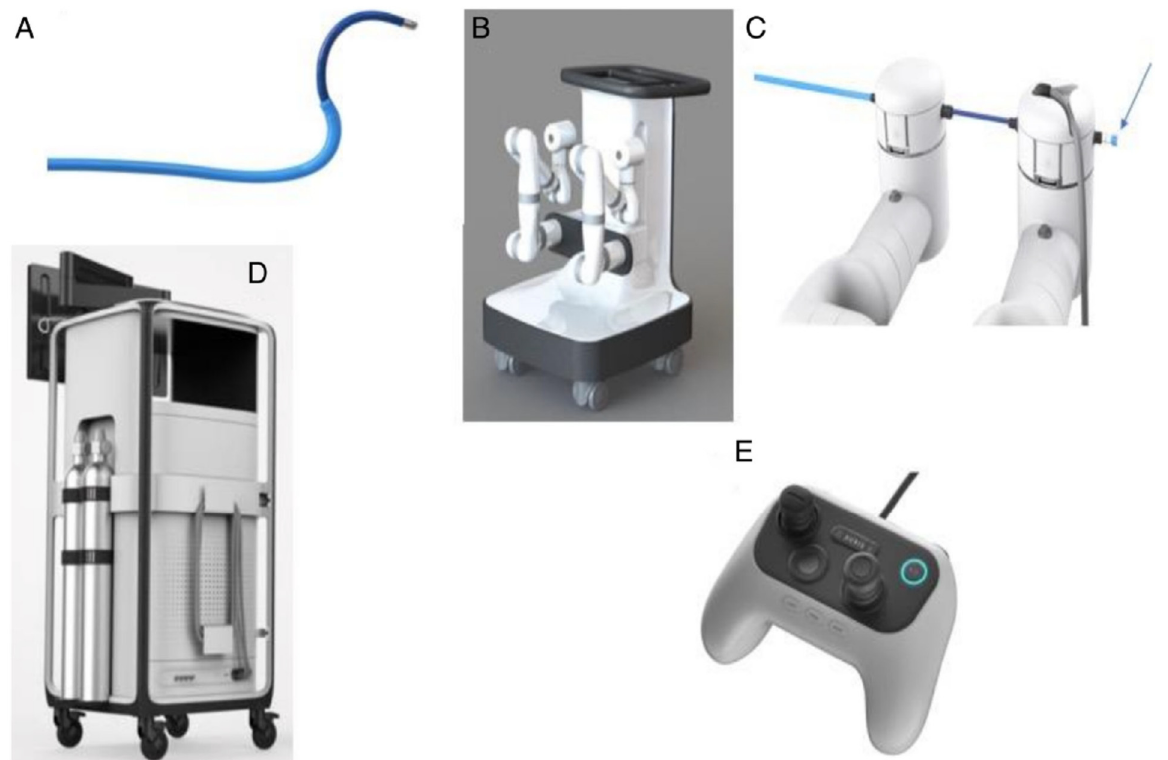
Figure 1. The Monarch TM Robotic System (Auris Robotics). Reproduced with permission from Dr. Septimiu Murgu, and July 2021. The system consists of ( A ) an outer sheath-inner scope bronchoscope assembly, ( B ) a cart with two robotic arms, ( C ) a scope-to-arm attachment with provision for pushing saline/air, suctioning and tooling (arrow), ( D ) a tower with a display monitor, and ( E ) the controller.